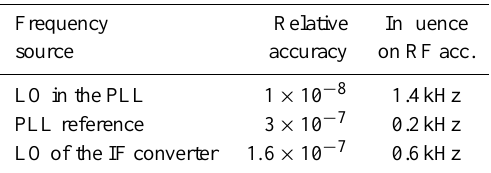
Table 1. Drifts over three days of the frequency sources (differ- ence between minimum and maximum value normalised by the mean frequency) and their influence on the accuracy of the radio frequency